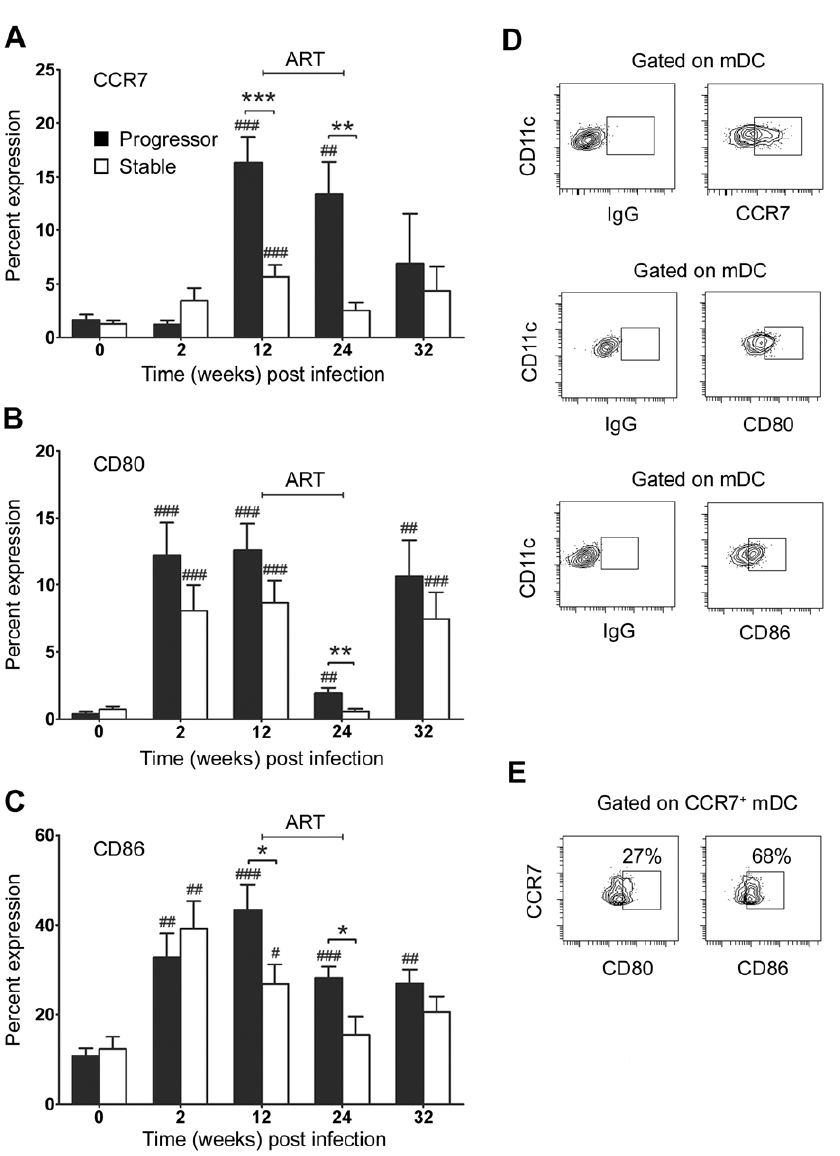
Figure 3. Differential activation of blood mDC in stable and progressive SIV infection. The proportion of blood mDC expressing CCR7 (A), CD80 (B) and CD86 (C) relative to staining with a control antibody before and at various times after SIV infection. Shown are mean 6 SEM for naı¨ve (n=19), progressor (n=8) and stable animals (n=10). (D) Representative flow cytometry plots of the gating strategy to identify positive populations. (E) Flow cytometry plots of CCR7 + mDC from progressor animal R180 at 12 weeks post infection labeled with antibodies to CD80 and CD86. Numbers represent the percentage of cells that co-express both markers relative to staining with a control antibody. Data are representative of three experiments on separate animals. * P , 0.05, ** P , 0.01, *** P , 0.005 between groups; # P , 0.05, ## P , 0.01, ### P , 0.005 within groups relative to week 0. ART=interval of antiretroviral therapy.